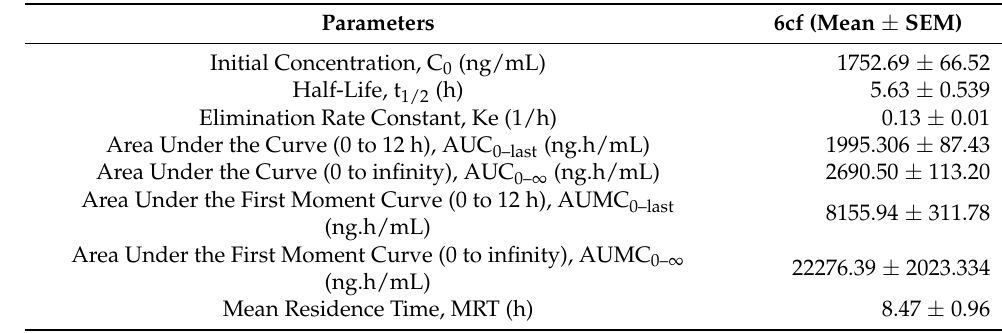
Figure 4. The pharmacokinetic profile for 6cf in rat plasma after i.v. bolus at dose of 10 mg/kg administration to rat. Table 4. The non-compartmental pharmacokinetic parameters for 6cf in rat plasma after i.v. bolus at dose of 10 mg/kg administration to rat .